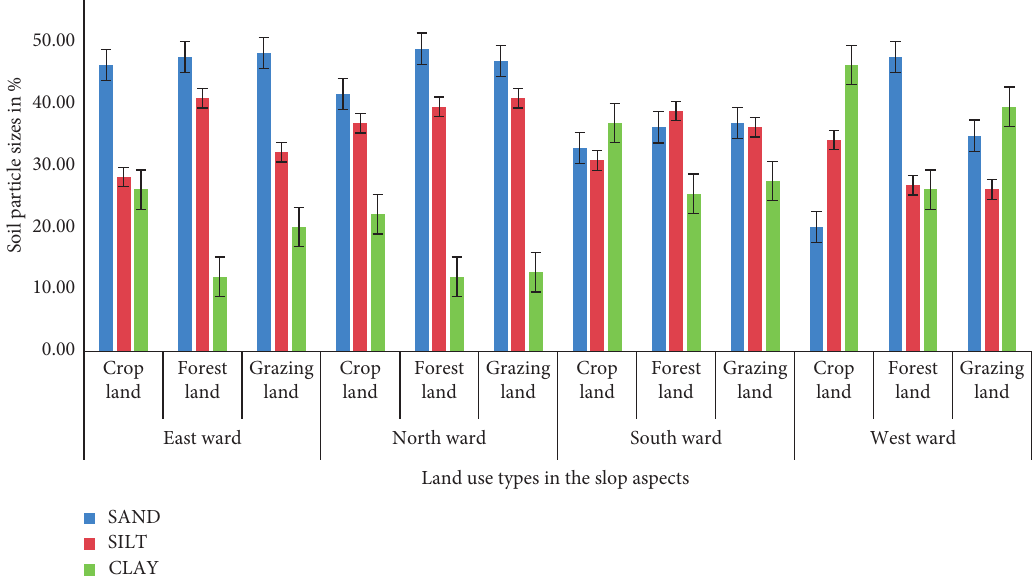
Figure 3: Particle size distribution among slope aspect and land use types.